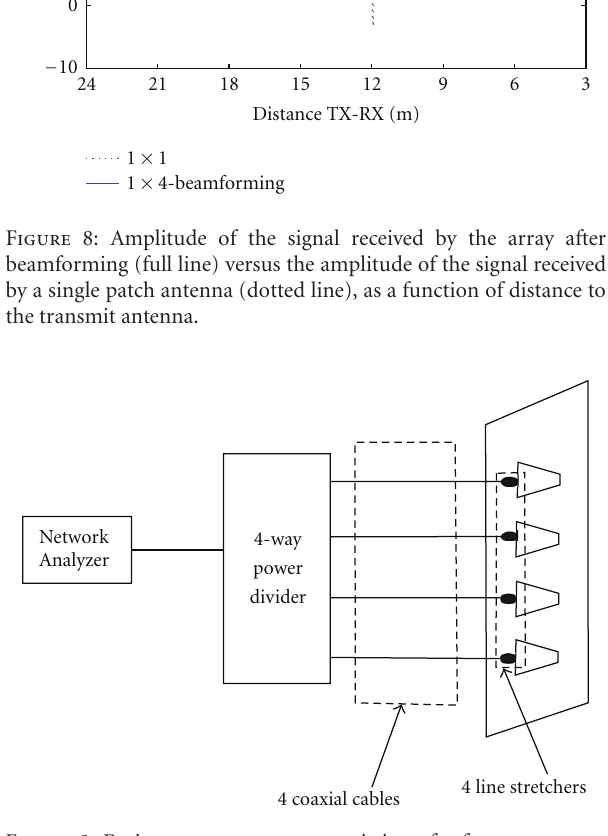
Figure 9: Entire antenna system, consisting of a four-way power divider, four cables, four line stretchers, and the textile antenna